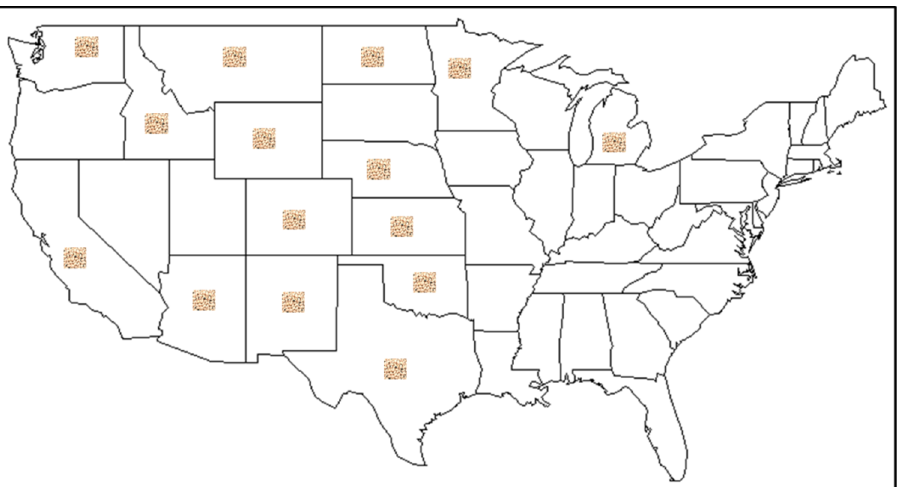
Figure 1. Major bean-producing states in the United States. Information was collected from the United States Dry Beans Commission